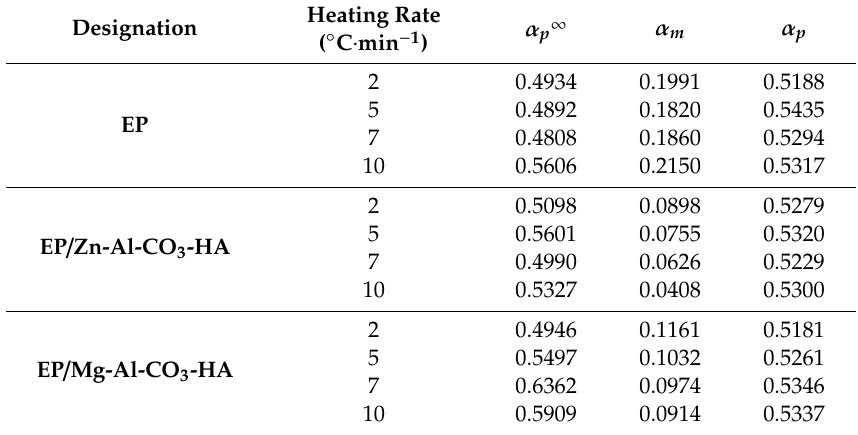
Table A1. The values of α p , α m , and α p ∞ obtained from the M á lek model at various heating rates.